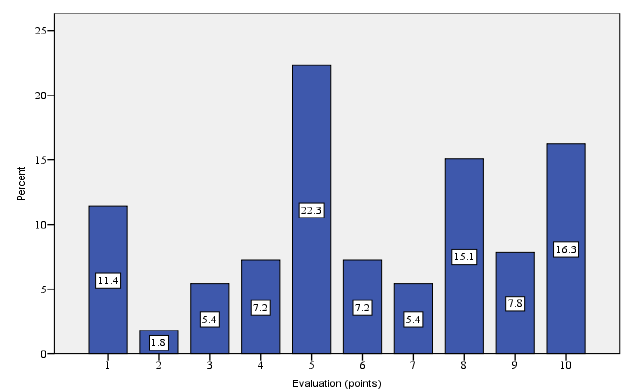
Fig. 2. Employers’ evaluation of the statement: “To what extent would your company be willing to participate in the pilot project of the dual world of work-based training implemented in cooperation with vocational schools?” Source: compiled by authors based on employers’ survey, 2013 ( n = 336). Evaluation scale 1–10, where 1 – not be ready; 10 – certainly be